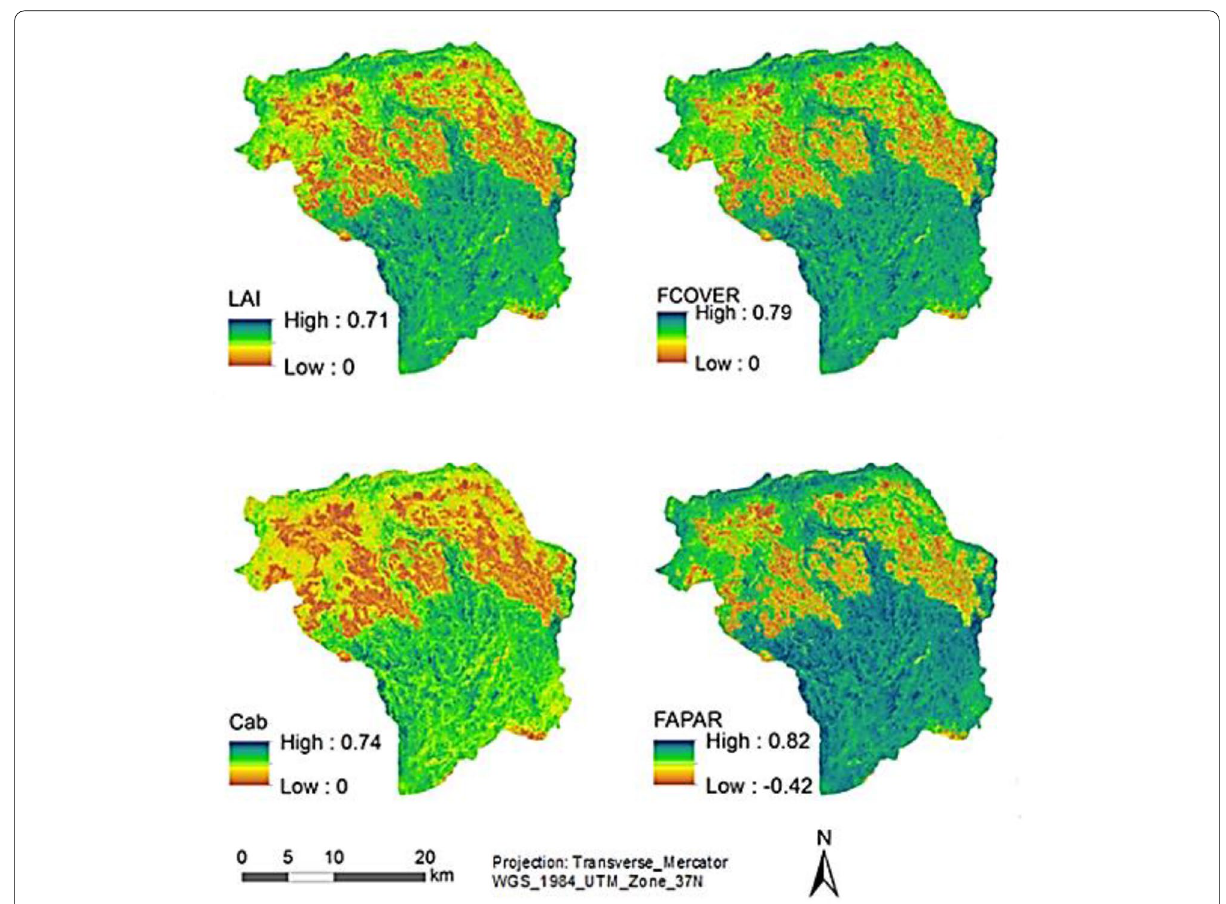
Fig. 6 Maps of the vegetation biophysical variables showing the highest and lowest surface reflectance values of the vegetation canopy and its spatial